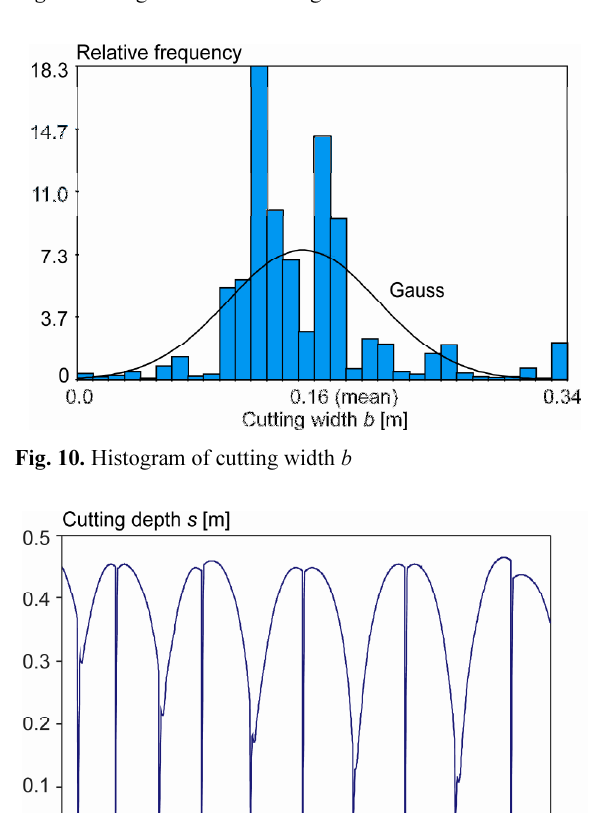
Fig. 9. Cutting width b vs. mining time